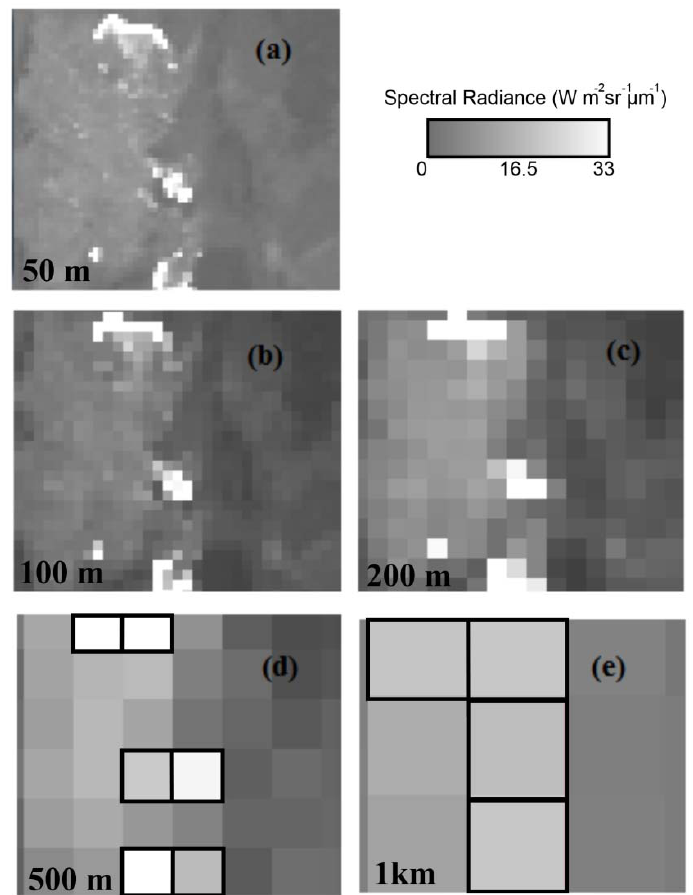
Figure 3. MODIS Airborne Simulator (MAS) imagery of cerrado fires burning in the northernmost MAS flight leg (bold box side highlighted in Figure 1a). Shown is a subset of data from that shown in Figure 1b, here depicted in the MAS low-gain middle infrared (MIR; 3.9 µ m) channel that has a spectral response very similar to that of the MODIS Band 21 ‘active fire’ 3.9 µ m channel. ( a ) The original MAS data with 50 m pixels, along with a legend displaying the spectral radiance scale. Bright pixels indicate those containing actively burning fires, albeit in generally filling only a small fraction of the 2500 m 2 pixel area. Using appropriately sized averaging kernels as outlined in the main text, the original 50 m MAS data were spatially degraded to four pixel sizes: ( b ) 100 m, ( c ) 200 m, ( d ) 500 m and ( e ) 1000 m. For clarity, in ( d , e ), the two coarsest spatial resolution datasets, the thick black lines outline the active fire pixels detected.